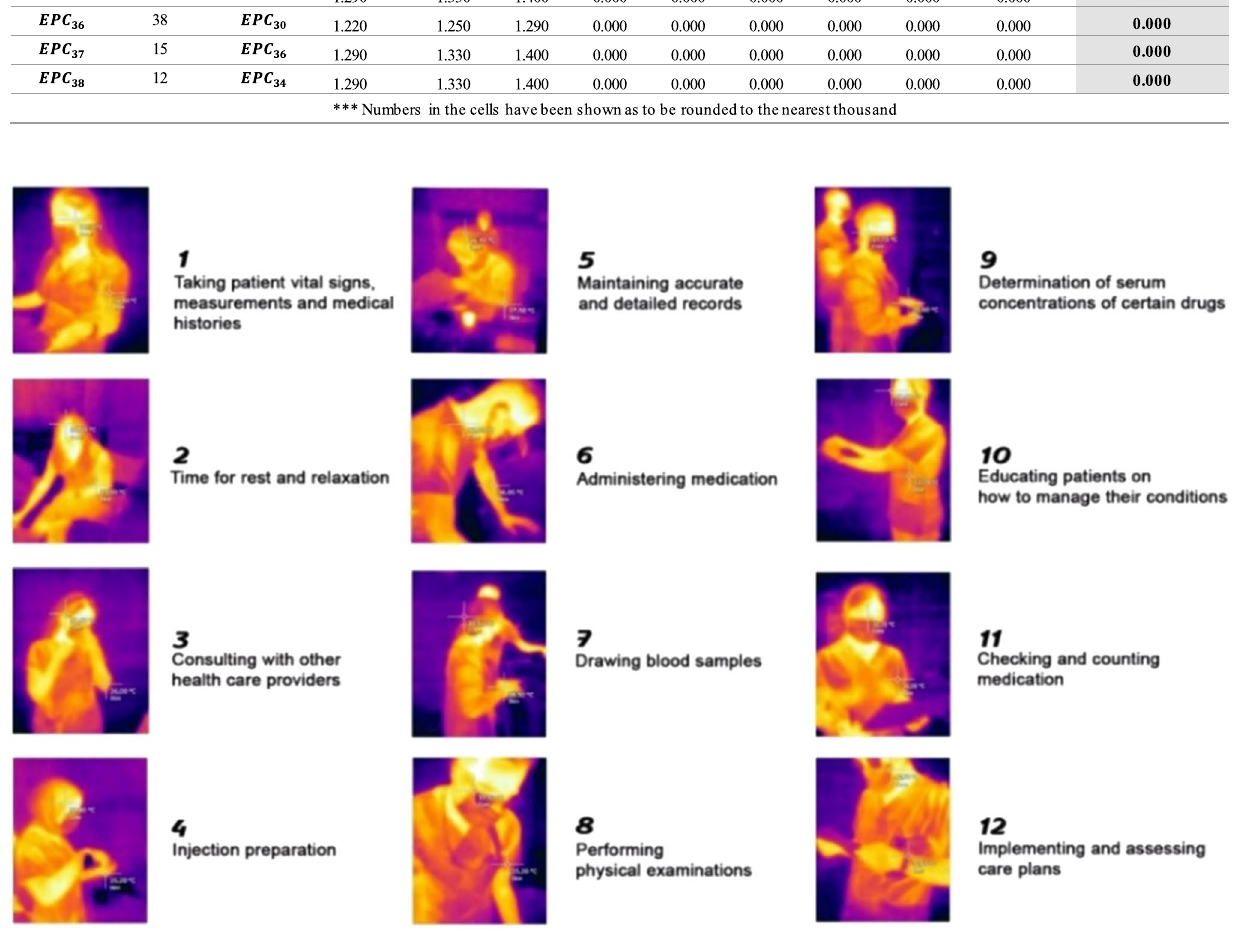
Fig. 4 Temperature measurements of